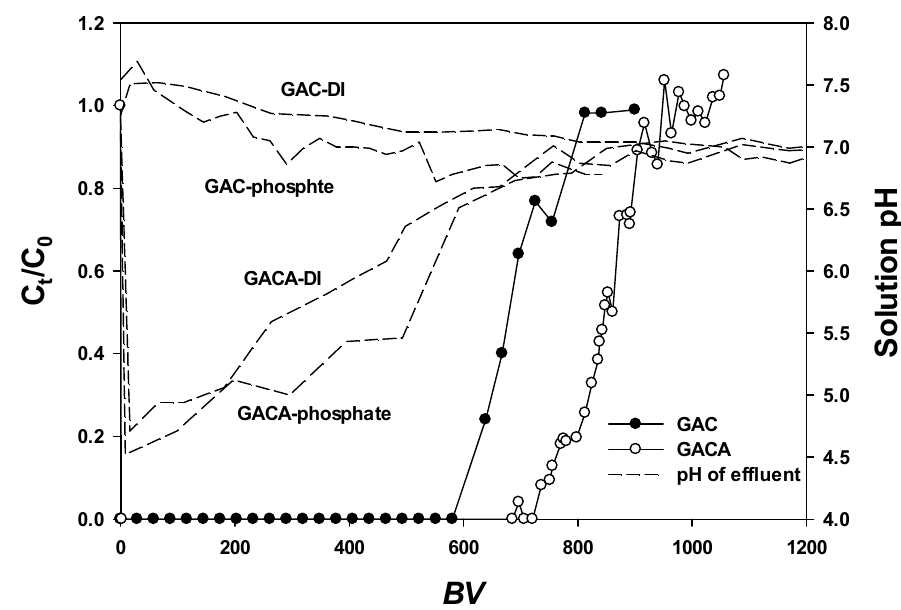
Figure 10. Phosphate breakthrough profiles for GAC and GACA and the effluent solution pH for deionized water (DI) and